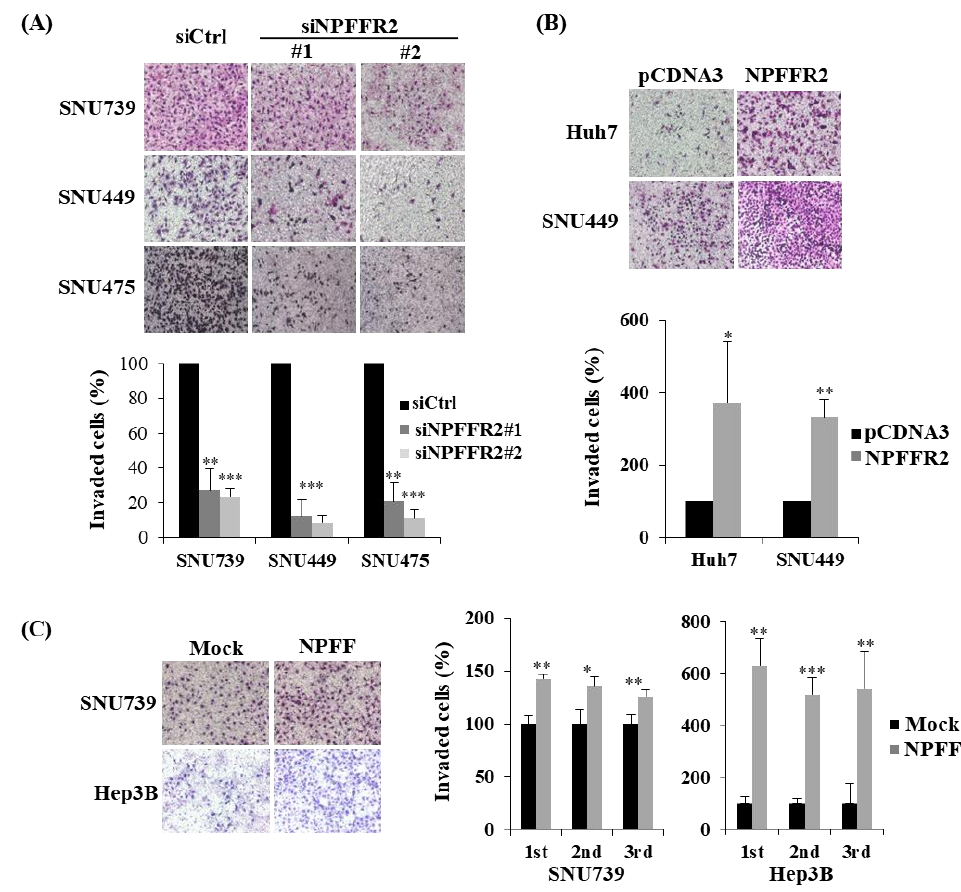
Figure 3. NPFFR2 increases invasiveness of cancer cells. ( A – C ) Transwell Matrigel invasion assay was performed with indicated HCC cells under conditions where NPFFR2 was depleted by siRNA ( A ), overexpressed by transient transfection ( B ), or activated by ligand ( C ). To verify invasion effect by regulation of NPFFR2 expression, cells transfected with siRNAs ( A ) or plasmid vector ( B ) for 24